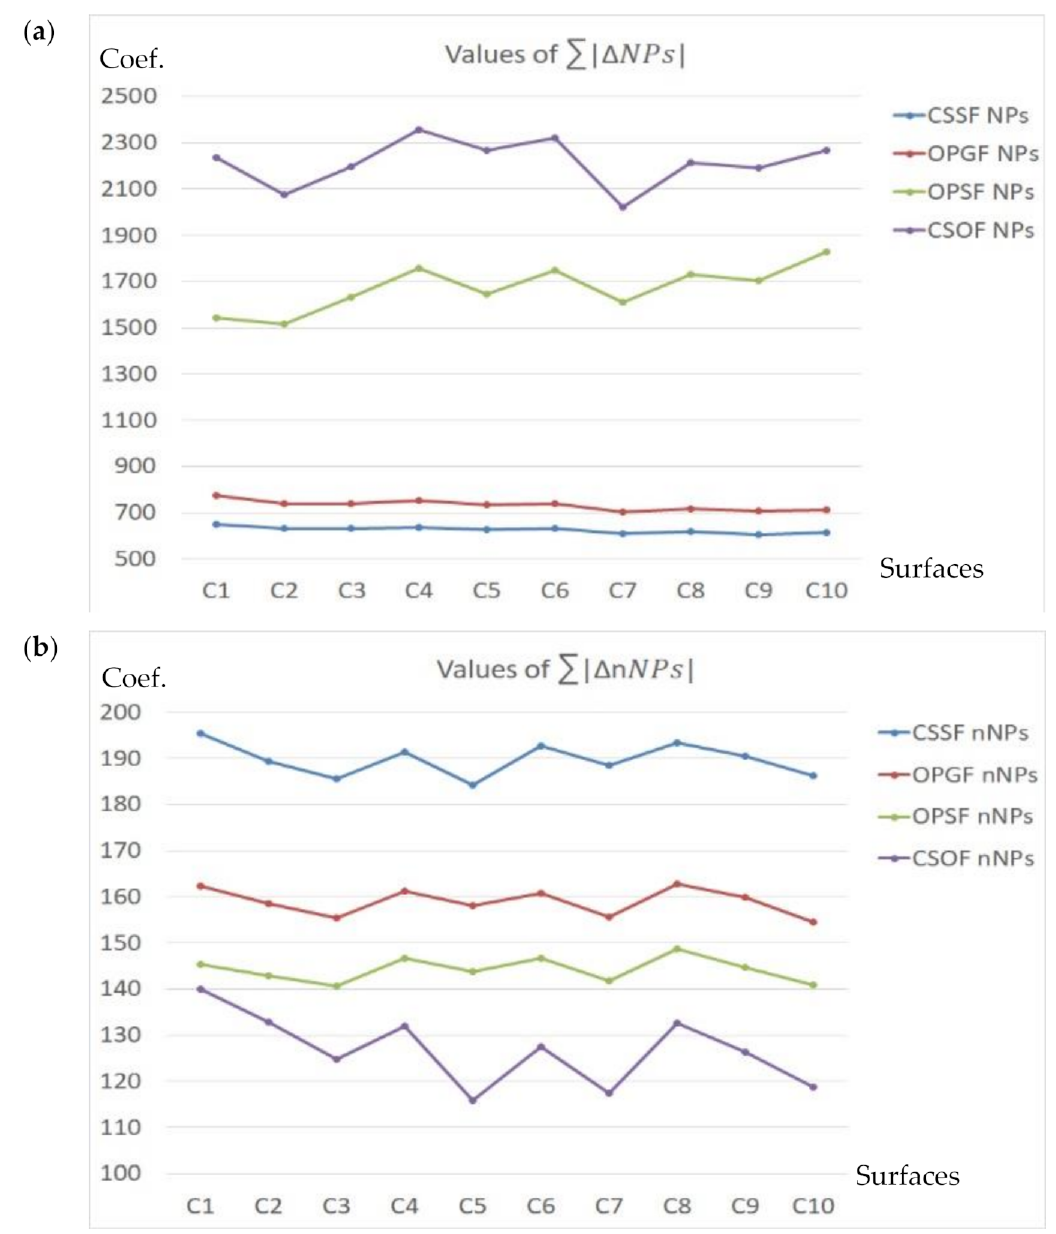
Figure 18. The values (presented in Coef. axis) of sums of NPs ( a ) and nNPs ( b ), described for plateau-honed cylinder liner